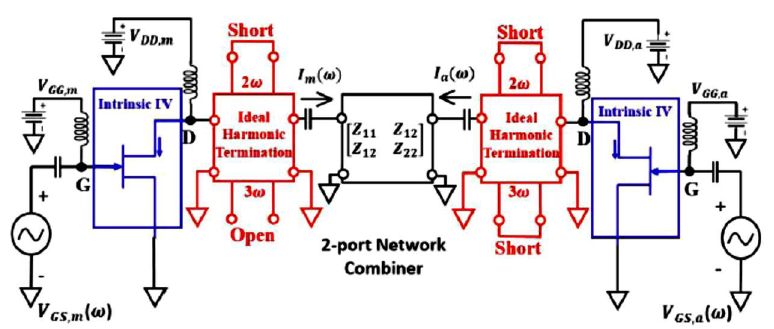
Figure 23. Hybrid Chireix-Doherty (HCD) PA prototype [122].